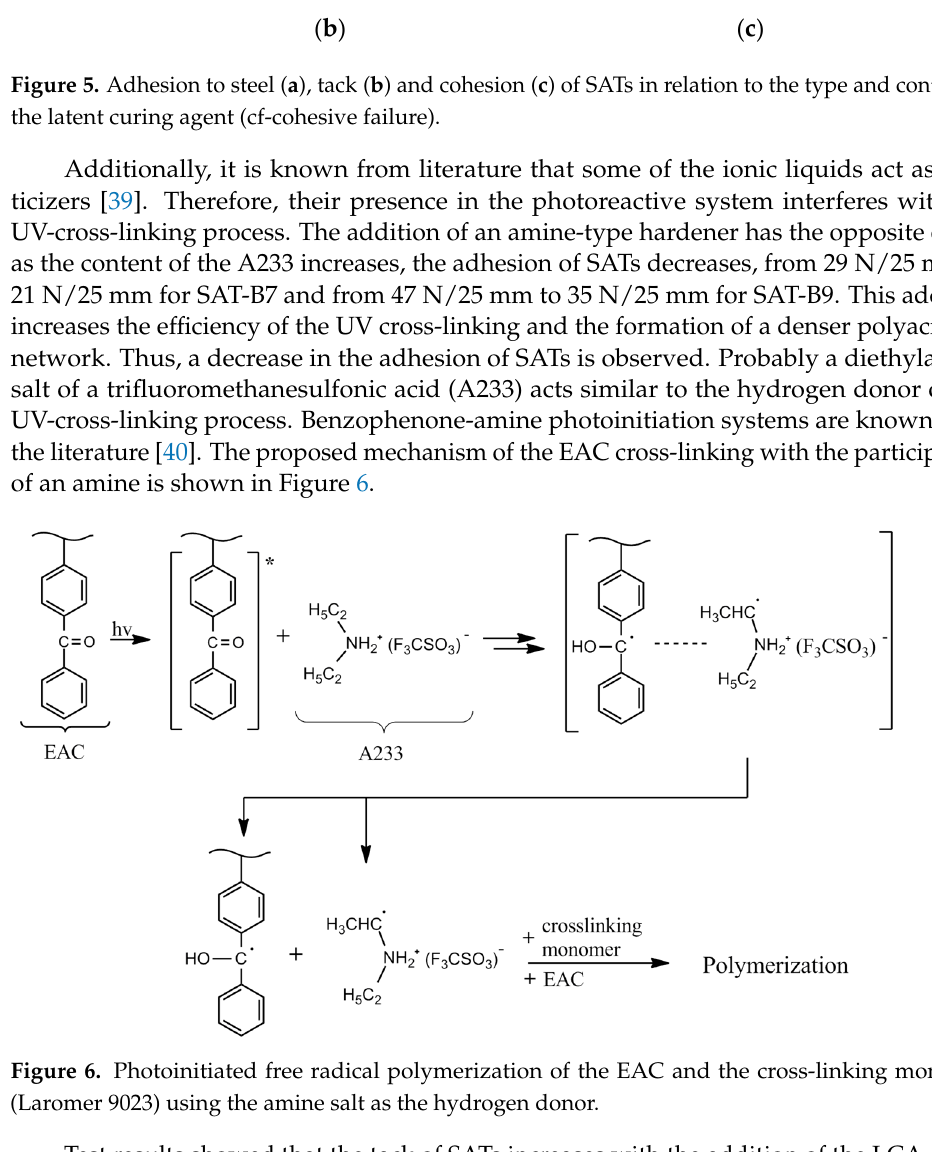
Figure 7. Photoinitiated free radical polymerization using the benzoxazine resin as the hydrogen donor.